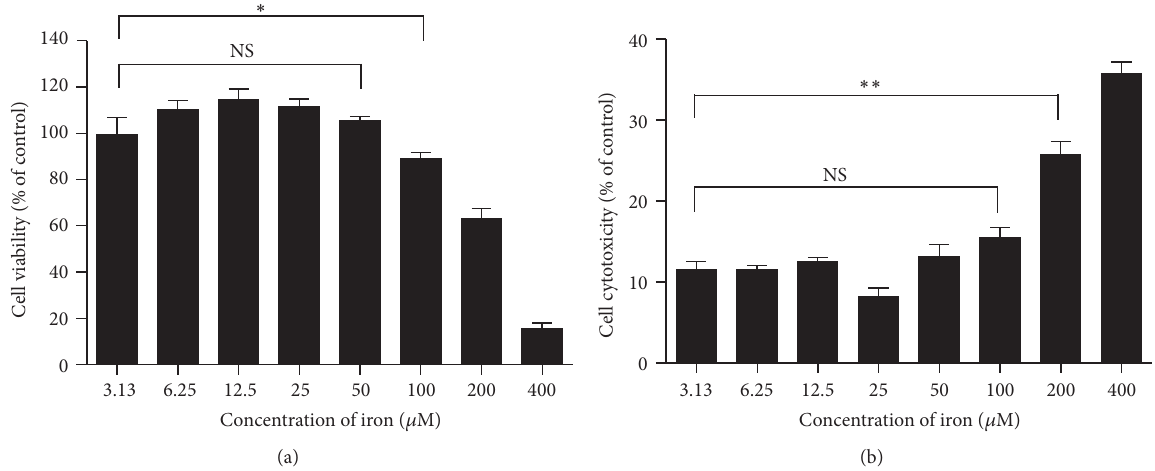
Figure 2: Determination of the noncytotoxic dose of iron. (a) RAW264.7 macrophage cells were incubated with FAC at range from 0 to 400 𝜇 g/mL for 24 h. Cell viability was determined by CCK-8 method. The results are expressed as the percentage of viable cells and represent mean ± SD of four samples. (b) Cell death was confirmed by measuring the release of the cytosolic marker LDH. LDH activity in the supernatant was measured as described in methods. ∗ 𝑝 < 0.05 and ∗∗ 𝑝 < 0.01 ( 𝑡